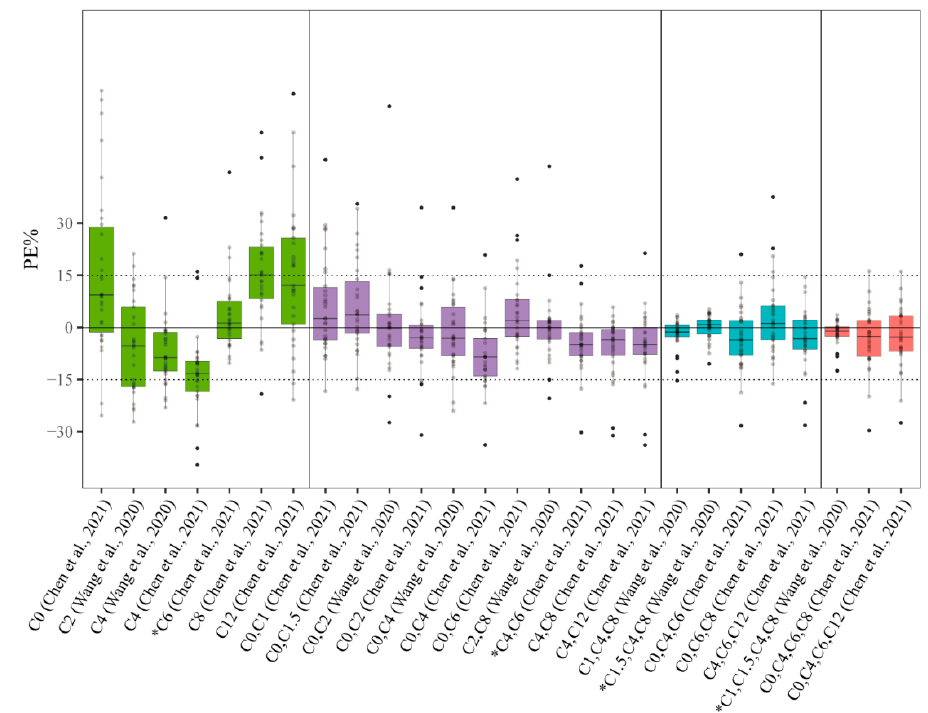
Figure 3. Boxplot of prediction error (PE%) of MLR-based PMB LSSs available in the literature for estimation of PMB AUC pred (Chen et al., 2021 [21] and Wang et al., 2020 [22]). The black solid line and dashed vertical lines represent 0% and ± 15% prediction error, respectively. Green, purple, blue, and red boxes represent LSSs consisting of single, two, three, and four concentration–time points, respectively. * Model with the best predictability within the same number of concentration– time points. Table 3. The predictive performance of best MLR-based PMB LSSs available in the literature for estimation of PMB AUC pred in patients with MDR Gram-negative bacteria infection treated with PMB.